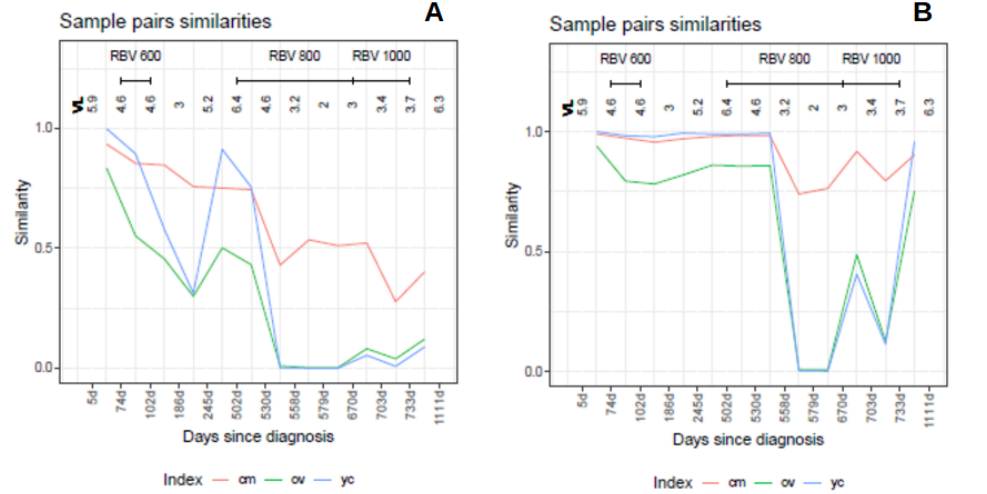
Figure 10. Distribution similarities in the composition of pairs of sequential samples in the HEV clinical case. ( A ) Haplotypes. ( B ) Phenotypes. Each point is the result of the comparison of two sequential samples, and is depicted in between the two compared samples. The segments above the figures show the time spanned by each treatment. Each sample is labeled as days since diagnosis.